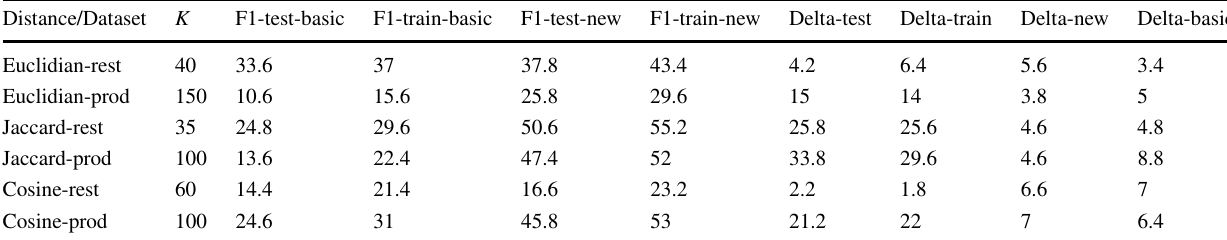
Table 6 F1-score average performances of NewKNN and BasicKNN in underfitting, for both datasets and using three distances with fivefold cross-validation